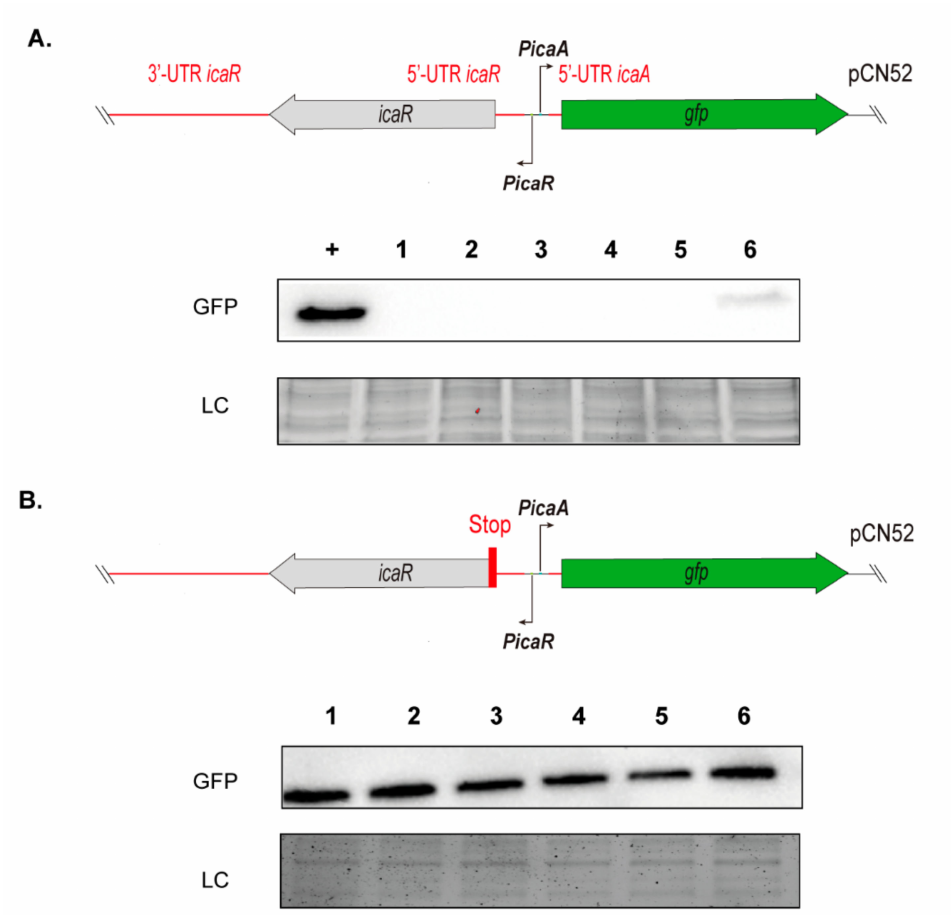
Figure 4. GFP protein levels in S. aureus 132 ica::tet expressing ica intergenic alleles- gfp reporter fusions. ( A ) Schematic representation of the transcriptional fusions of the ica intergenic alleles amplified from each representative PJI isolate with the gfp gene in the pCN52 plasmid. The Western blot shows GFP protein levels in the S. aureus 132 ica::tet strain expressing the reporter fusions. +; a reporter plasmid containing the ica intergenic allele of the S. aureus 15981 strain was used as a positive control. LC; a stain-free gel portion is included as loading control. ( B ) Analysis using reporter fusions containing a stop codon in the icaR coding